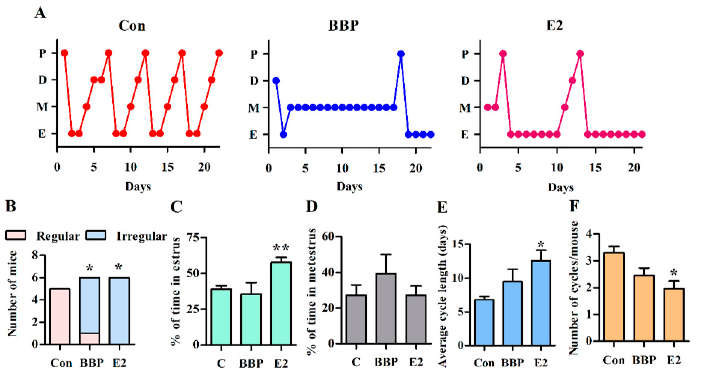
Figure 6. BBP disrupts the estrous cycle. ( A ) Estrous cycles for representative control (Con), BBP- treated (1.5 mg/kg BW/day), and E2-treated (50 µg/kg BW/day) mice over 22 days of treatment. D, diestrus; E, estrus; M, metestrus; P, proestrus. ( B ) The number of mice with regular and irregular cycles in each group (Mid-P exact test, * p < 0.05). ( C – F ) The percentage of time spent in the estrus ( C ) and metestrus ( D ), average cycle length ( E ), and the number of cycles per mouse ( F ). The percentage of time was determined based on the days in the full treatment days. Data are pooled from two independent experiments (control, n = 5; BBP, n = 6; E2, n = 6). Results are shown as the mean ± SEM. * p < 0.05; ** p < 0.01 vs. control using the Mann–Whitney U test.